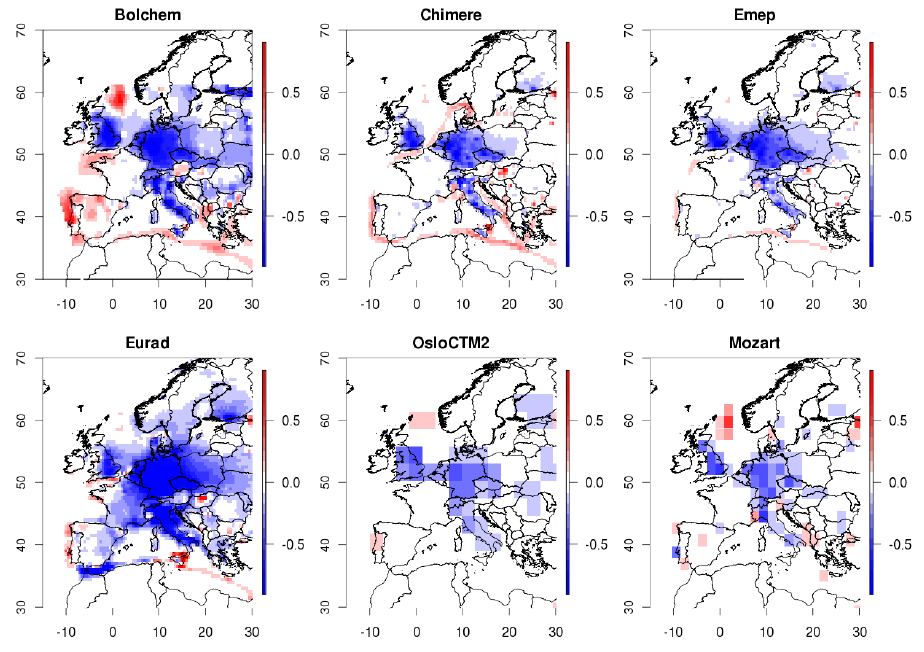
Figure 7: Modelled NO 2 trend (µg/m3/yr) for each CTM and at each grid point computed Fig. 7. Modelled NO 2 trend (µgm − 3 yr − 1 ) for each CTM and at each grid point computed on the basis of monthly means of daily means on the basis of monthly means of daily means over the 1998-2007 period with a linear over the 1998–2007 period with a linear least square fit of de-seasonalised least square fit of de-seasonalised values.